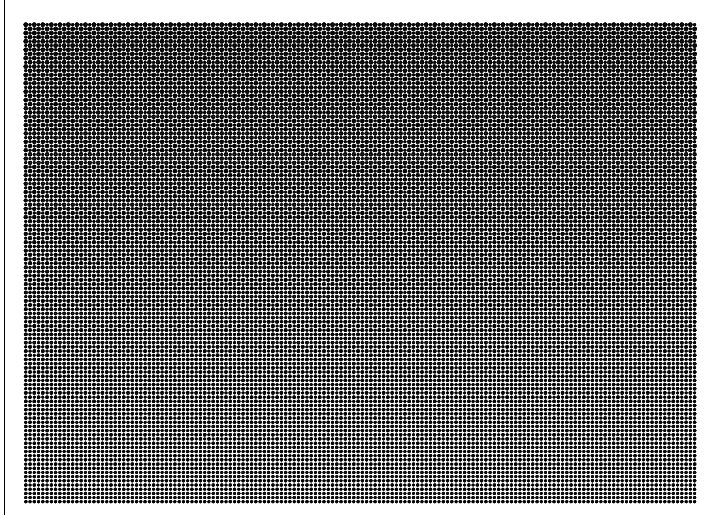
Figure 7. The ultimate microstructure distribution of light guide plate. Table 4. S/N ratio for optimum design of microstructure of LGP.